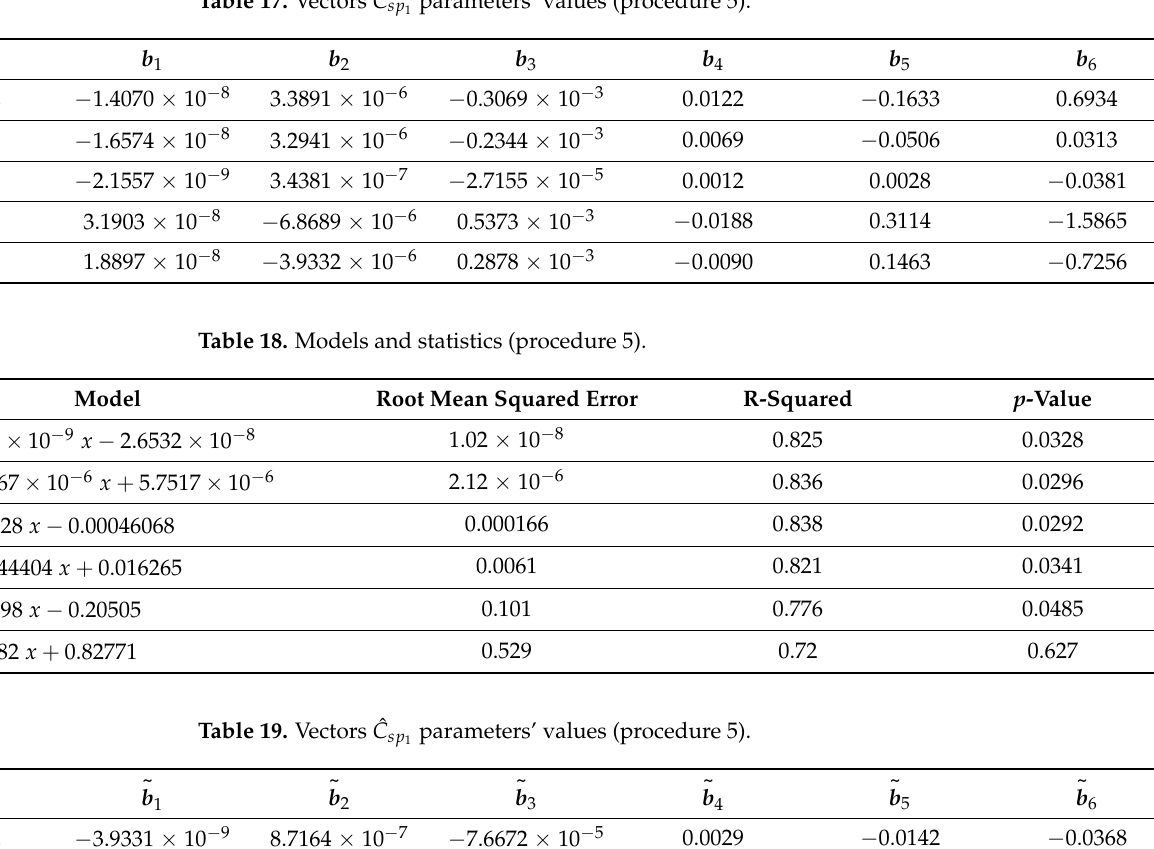
Table 17. Vectors ˇ C sp